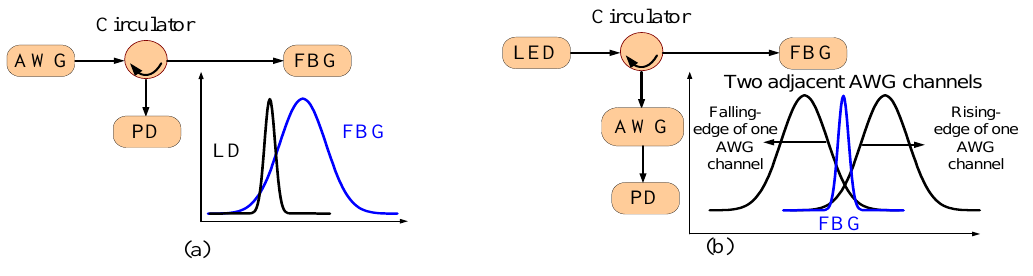
Figure 7. FBG interrogation system using. (a) laser diode (LD) and (b)